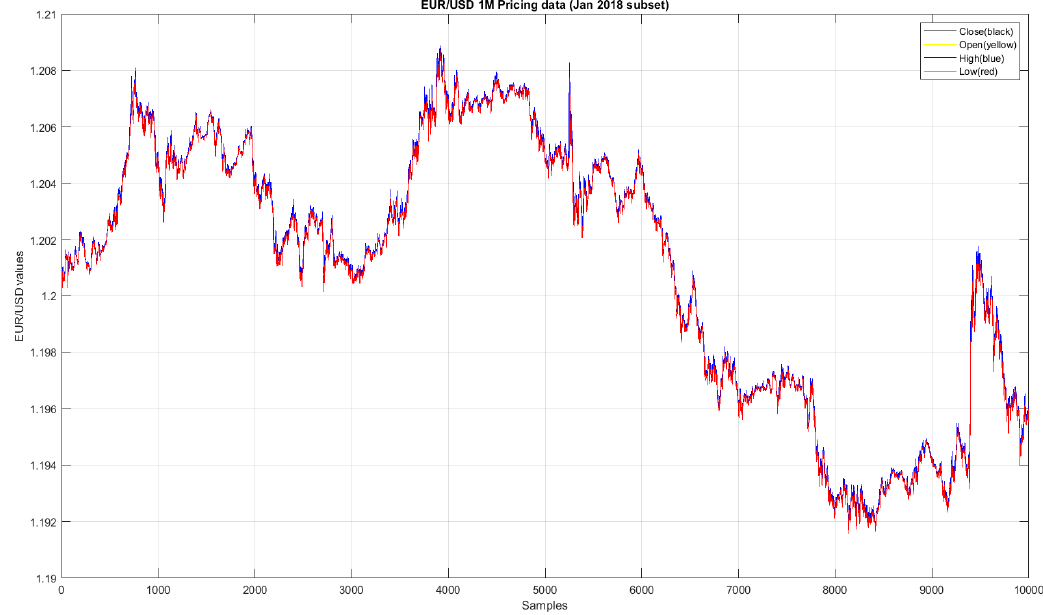
Figure 2. The EUR / USD prices time-series (January 2018) Figure 2. The EUR/USD prices time-series (January 2018) .